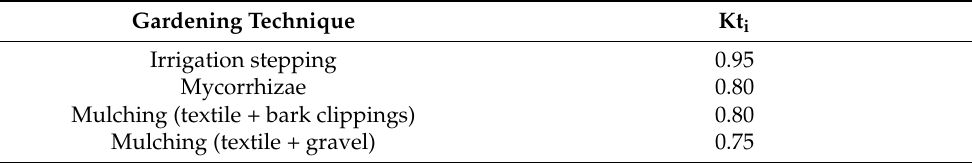
Table 8. Examples of efficiencies (Kt i ) for different gardening